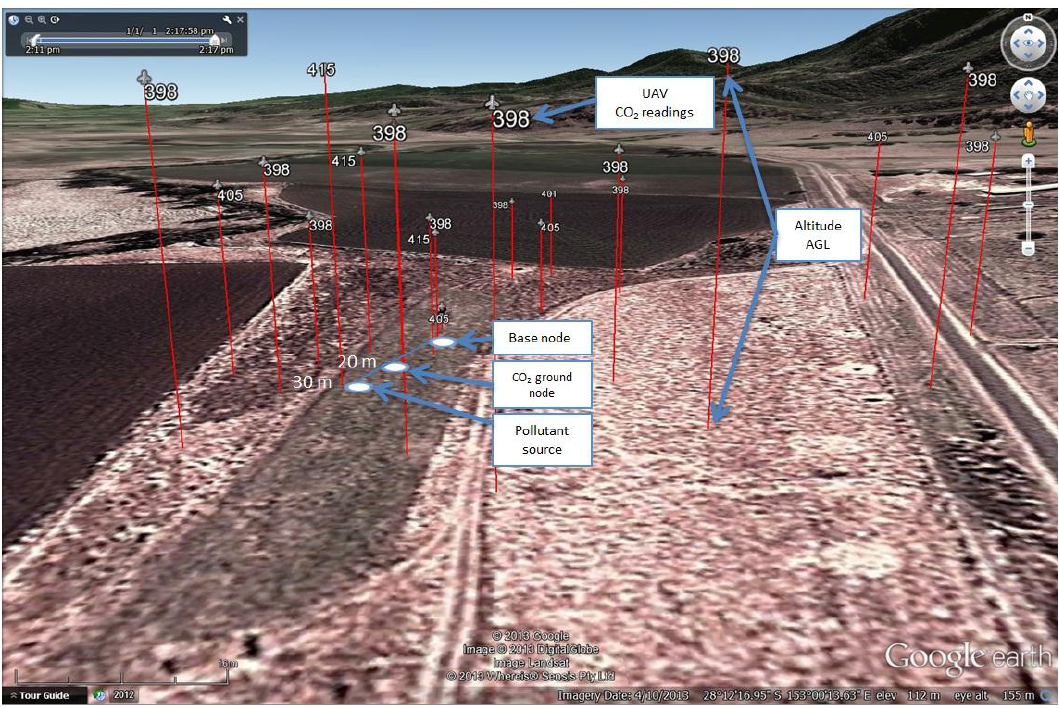
Figure 20. Geo-location and values of the CO 2 samples taken by the UAV during the field testing in Christmas Creek, 23 July